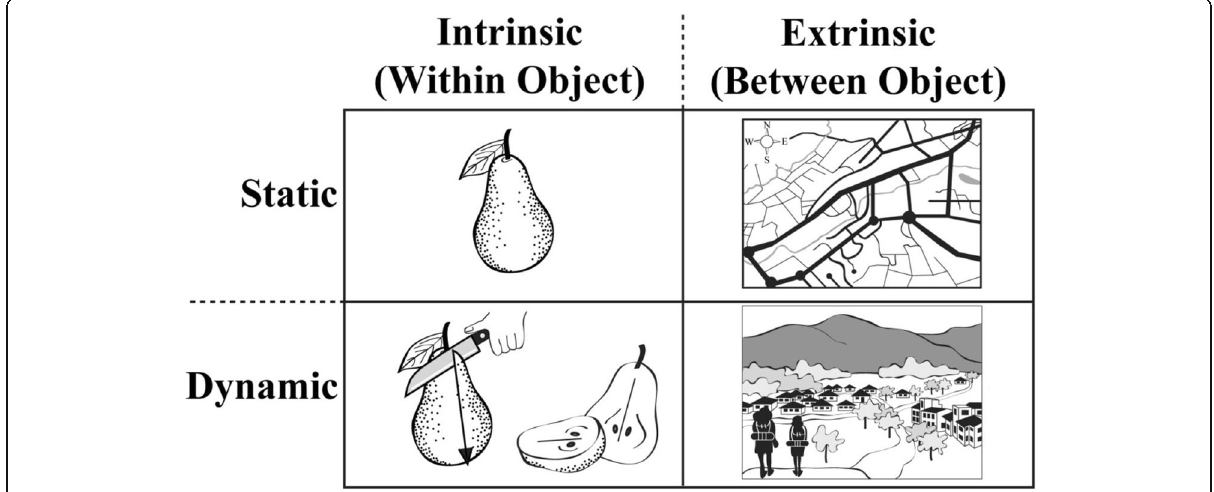
Fig. 1 Categorization of spatial skills by intrinsic/extrinsic object information and static/dynamic movement